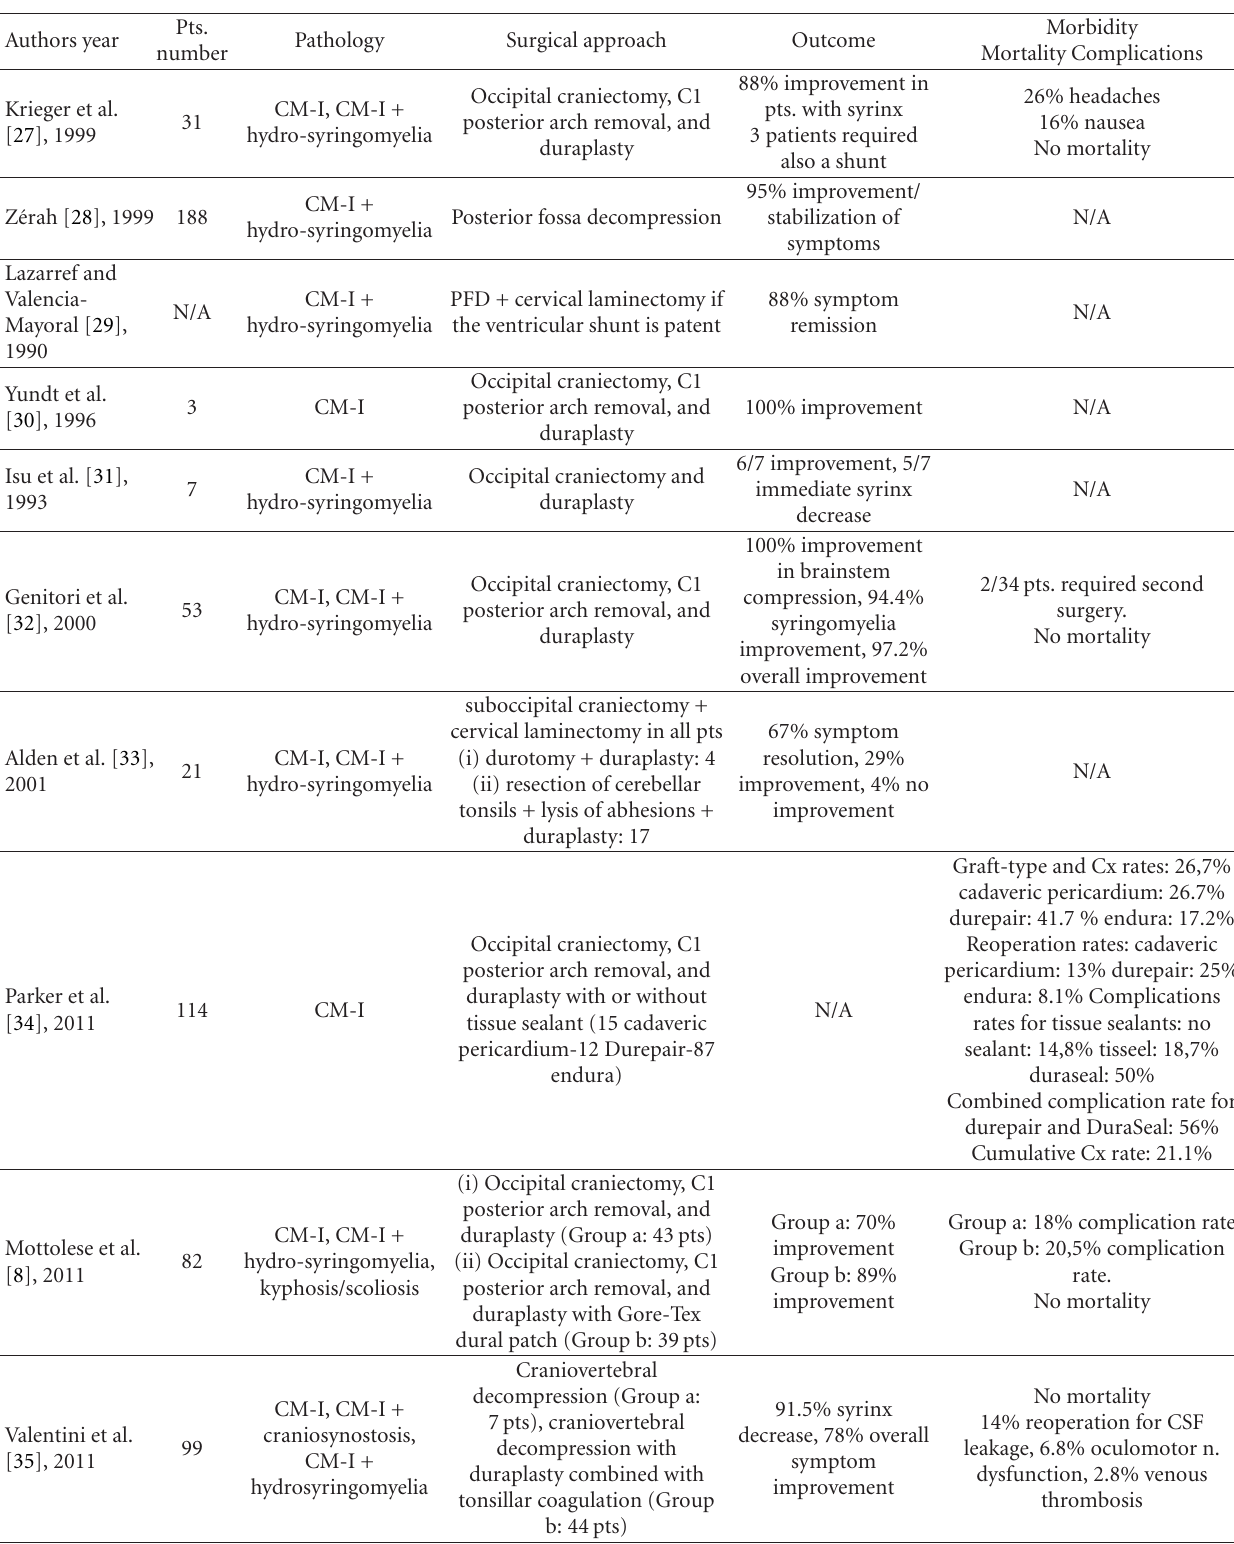
Table 1: Synopsis of previously published clinical series including the number of their patients, the underlying pathologies, the employed surgical approach, and the outcome and complication rates. Pts. Authors year Krieger et